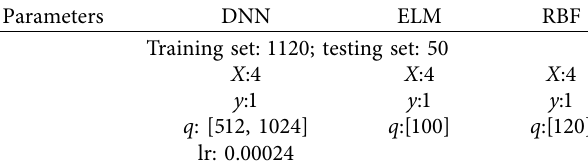
Figure 9: RBF prediction. Table 3: Simulation parameters for Figures 7–9. Parameters